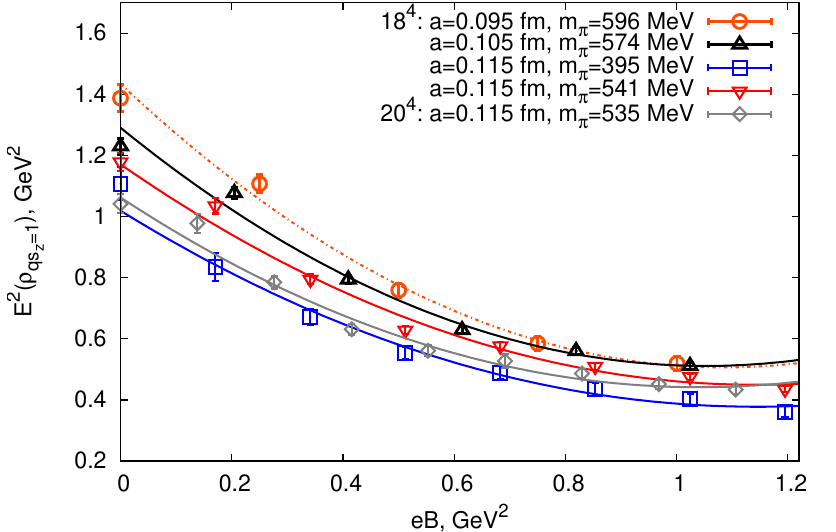
Figure 3 . The energy squared of the charged (cid:26) meson for the case qs z = +1 depending on the magnetic (cid:12)eld value for various lattice data sets. The solid lines correspond to the (cid:12)ts of the lattice data obtained with the use of formula